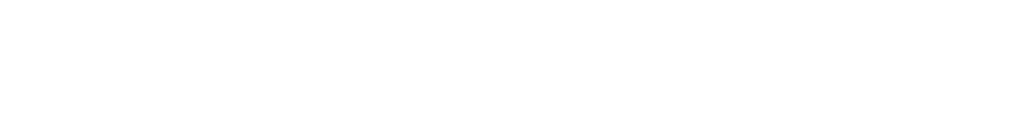
Logopediese Vereniging, Vol. 17, Nr. 1: Des.